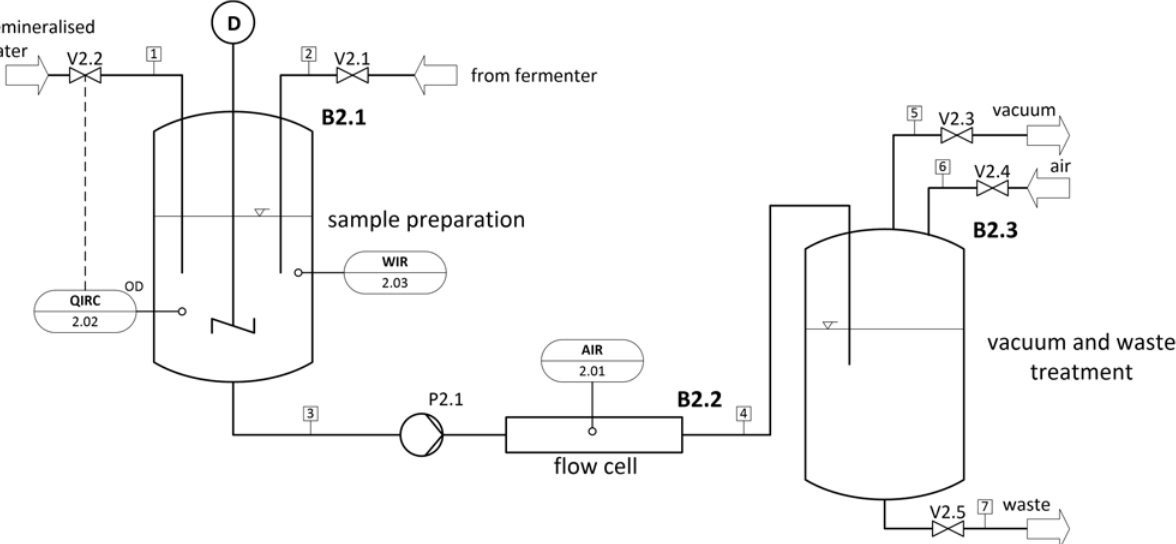
Fig 2. Simplified flow chart of the sample preparation, image acquisition, vacuum and waste treatment. The measurement of OD at 600 nm (QIRC 2.02) regulates the dilution of the sample (stream 1). The degree of sample dilution is registered using weight control (WIR 2.03). In the flow cell, the image acquisition (AIR 2.01) can start after evacuating the